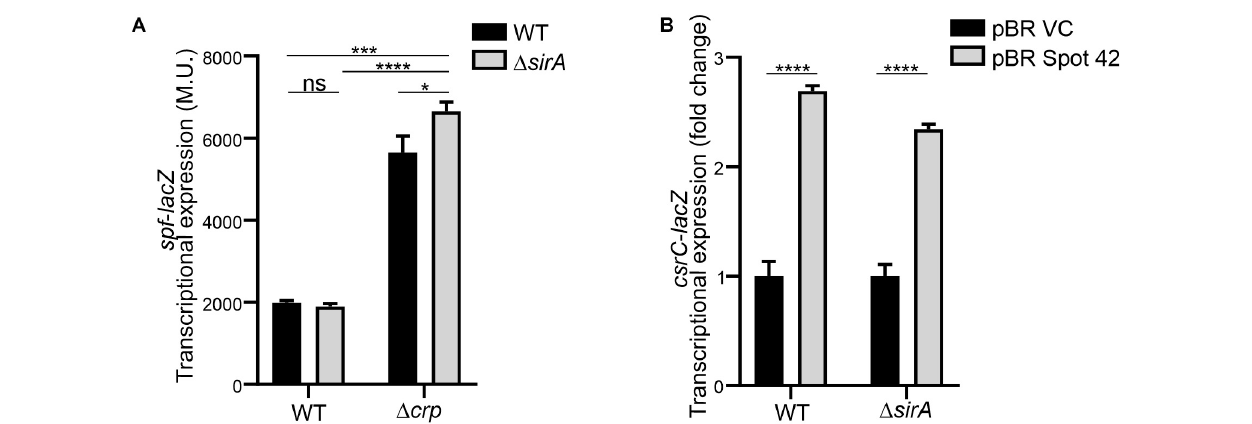
FIGURE 5 | Spot 42 regulates CsrC in a SirA-independent manner. (A) Transcriptional expression of the chromosomal spf - lacZ fusion (Spot 42 expression) was monitored in WT, (cid:49) crp , (cid:49) sirA, and (cid:49) crp (cid:49) sirA genetic backgrounds. (B) Transcriptional expression of the chromosomal csrC - lacZ fusion upon ectopic expression of the sRNA Spot 42 compared to the strain carrying the control vector (pBRplacVC) in a WT and a (cid:49) sirA backgrounds. The transcriptional expression is shown in relative values. In each case, the reference (pBRVC) was set as 1.0. Miller units of the pBRVC backgrounds were 159 ± 21 and 20 ± 2.2 for WT and (cid:49) sirA, respectively. In all cases, cultures were grown in LB at 37 ◦ C up to an OD 600 nm of 0.4. β -galactosidase activity was determined for three independent cultures, average and standard deviation are presented. * p < 0.05; *** p < 0.001; **** p < 0.0001; ns, not significant.